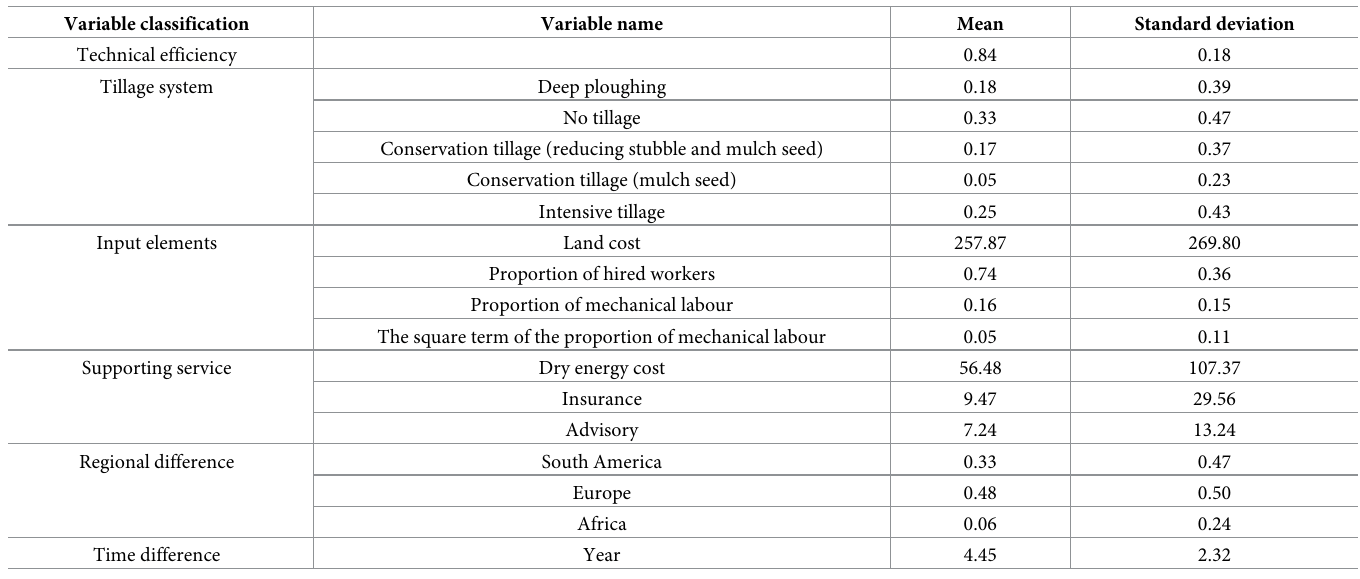
Table 3. Model variable settings and descriptive